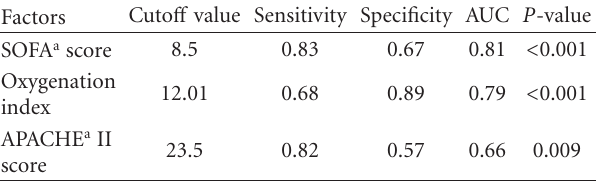
Table 5: Comparison of cuto ff value, sensitivity, specificity, AUC a , and P -value between physiological severity scores.